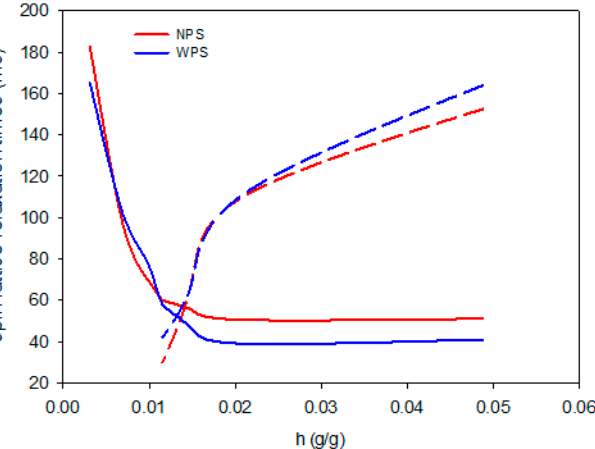
Figure 4. Changes in the short T 11 (solid) and long T 12 (dashed) components of spin-lattice relaxation times during hydration of native potato starch aerogels.